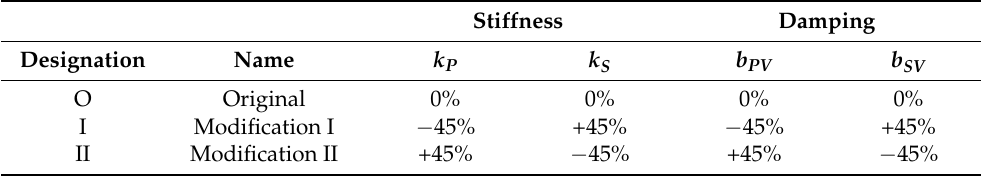
Table 3. A list of the parameters of the spring-damper elements.